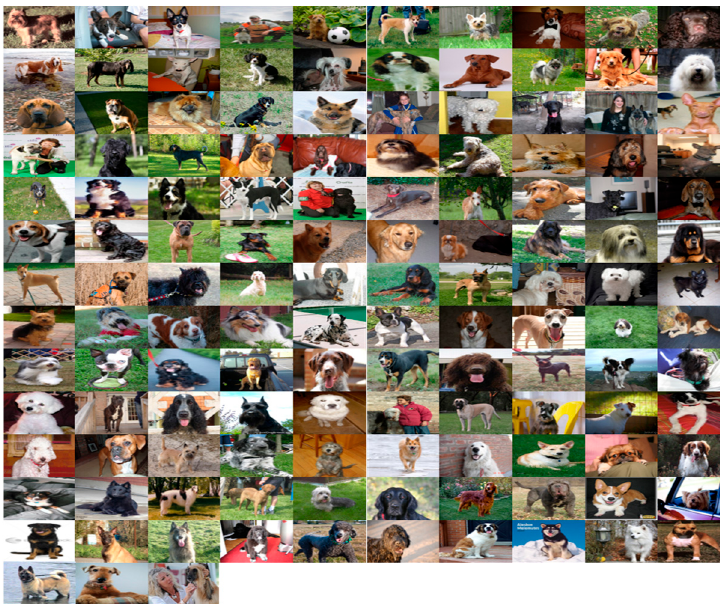
Figure 11. Some images of the TestSet1.